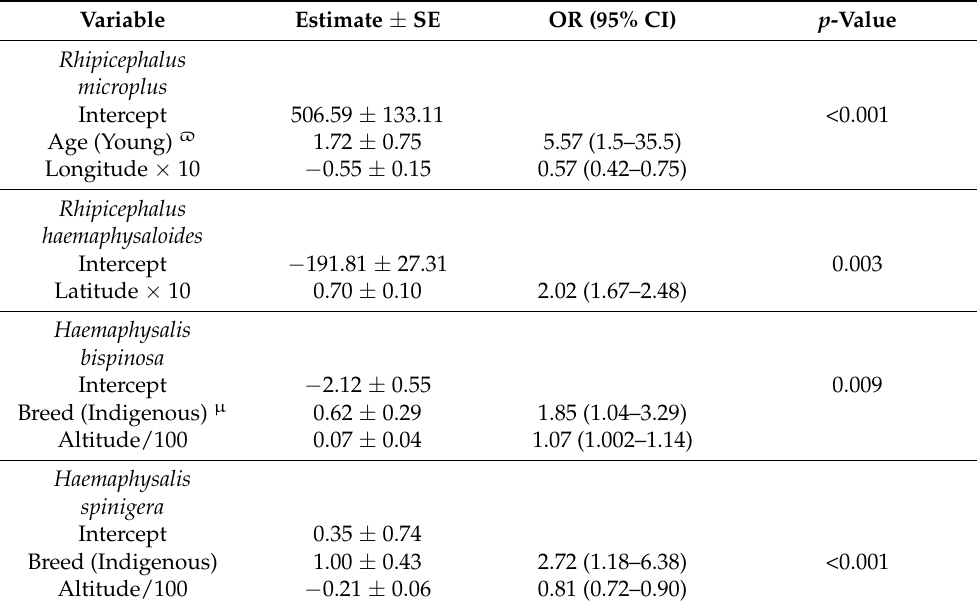
Table 6. The final multiple logistic regression models to understand factors associated with infestation prevalence of each tick species (categorized as infested or not) in